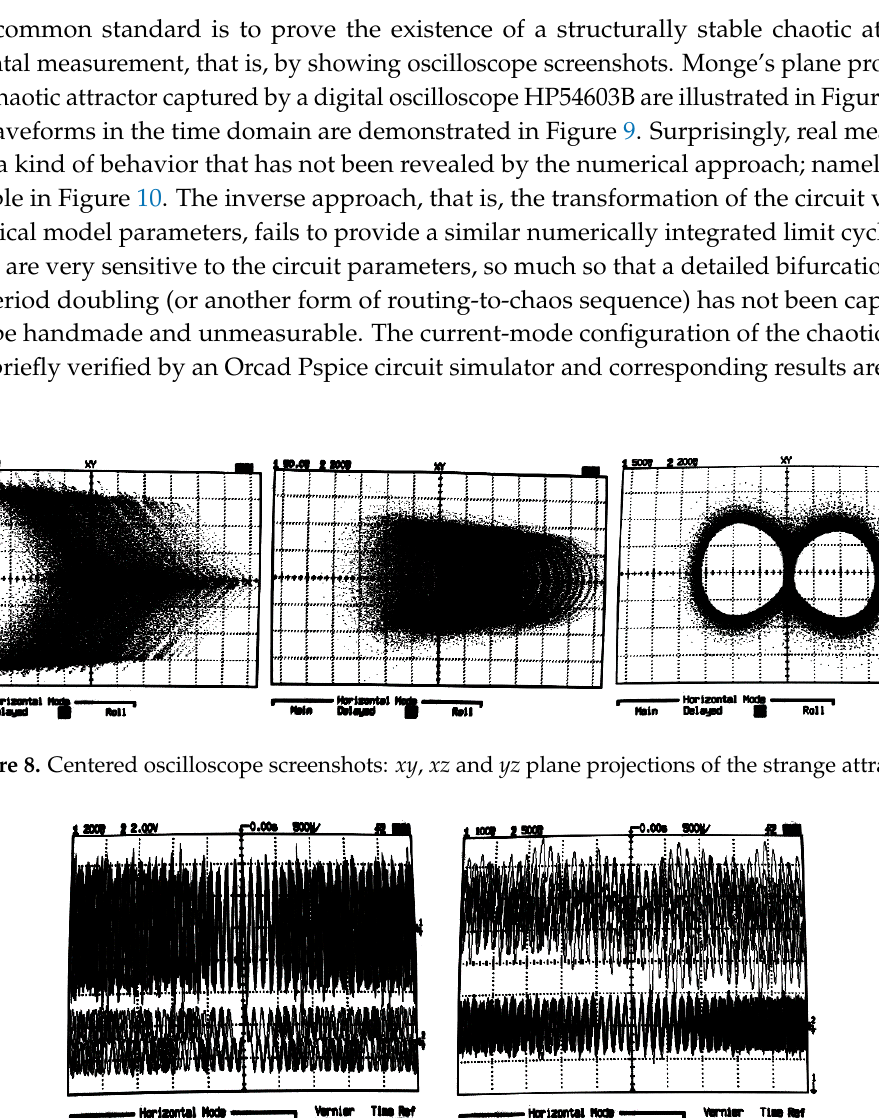
Figure 9. Oscilloscope screenshots: chaotic signals in time domain.